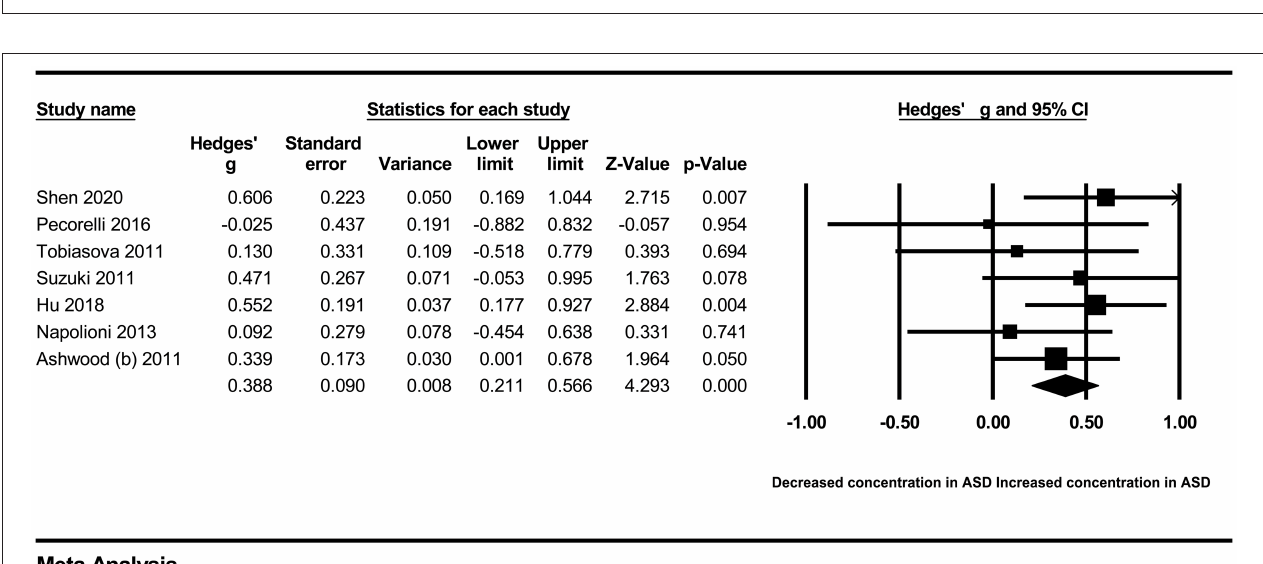
FIGURE 3 | Forest plot for the random-effects meta-analysis (IL-1 β ).